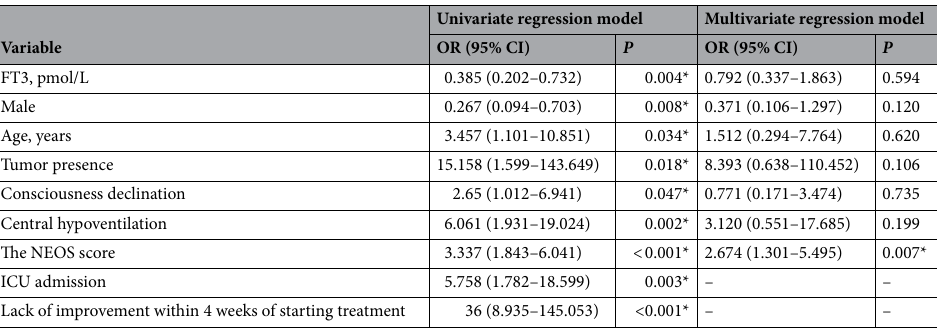
Table 3. Univariate and multivariate analysis of predictors obtained within 4 weeks of starting treatment for poor one-year outcome. In the univariate model, the eligible variables obtained within 4 weeks of starting treatment were analyzed and those identified as not predictors of poor one-year outcome ( P > 0.05) were not shown in this table. In the multivariate regression model, the predictive value of FT3 was adjusted by gender, age, consciousness declination, tumor presence, central hypoventilation and the NEOS score. OR, odds ratio; CI, confidence interval; FT3, free triiodothyronine; ICU, intense care unit; NEOS, anti-NMDAR Encephalitis One-Year Functional Status.